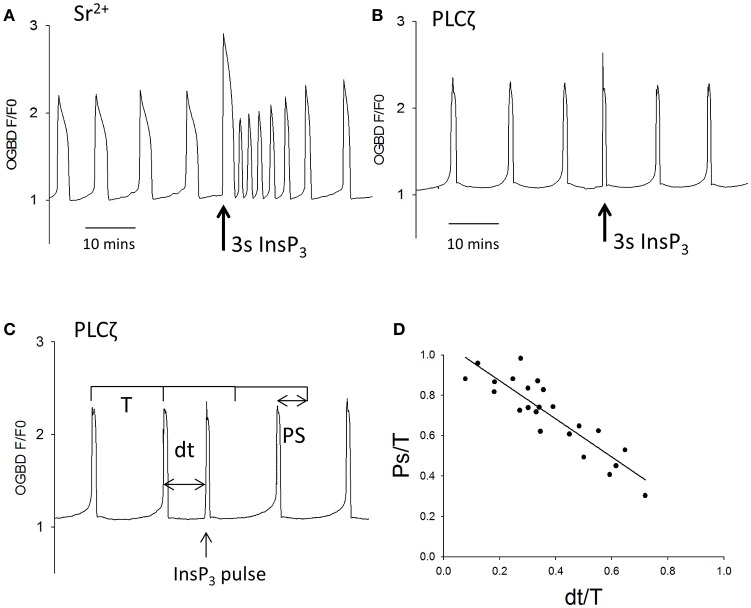
The effect of large pulses of InsP3 on PLCζ or Sr2+ triggered Ca2+ oscillations. (A) shows an example of the way eggs responded a large uncaging pulse of InsP3 (3 s UV light at the arrow) by an increase in the frequency of Sr2+ triggered Ca2+ oscillations (n = 20 eggs). There was a significant increase in frequency of Ca2+ spikes from 3.45 (±0.27 sem) in 20 min to 5.05 (±0.35 sem) in 20 min (p < 0.001). In (B) a similar experiment is shown but with PLCζ induced Ca2+ oscillations. The sample trace in (B) shows that a 3 s uncaging pulse of InsP3 (at the arrow) caused an immediate Ca2+ increase but no increase in frequency (n = 23 eggs). We analyzed the ability of such pulses to reset the phase of oscillations by measuring then phase shift (PS) and comparing it to time delay (dt) at which the InsP3 pulse was applied. (C) Illustrates how these values were measured on an actual sample trace. Each value was divided by the time-period (T) for the oscillations in order to normalize the values between different eggs. (D) Shows a plot of these values for all 23 eggs tested.